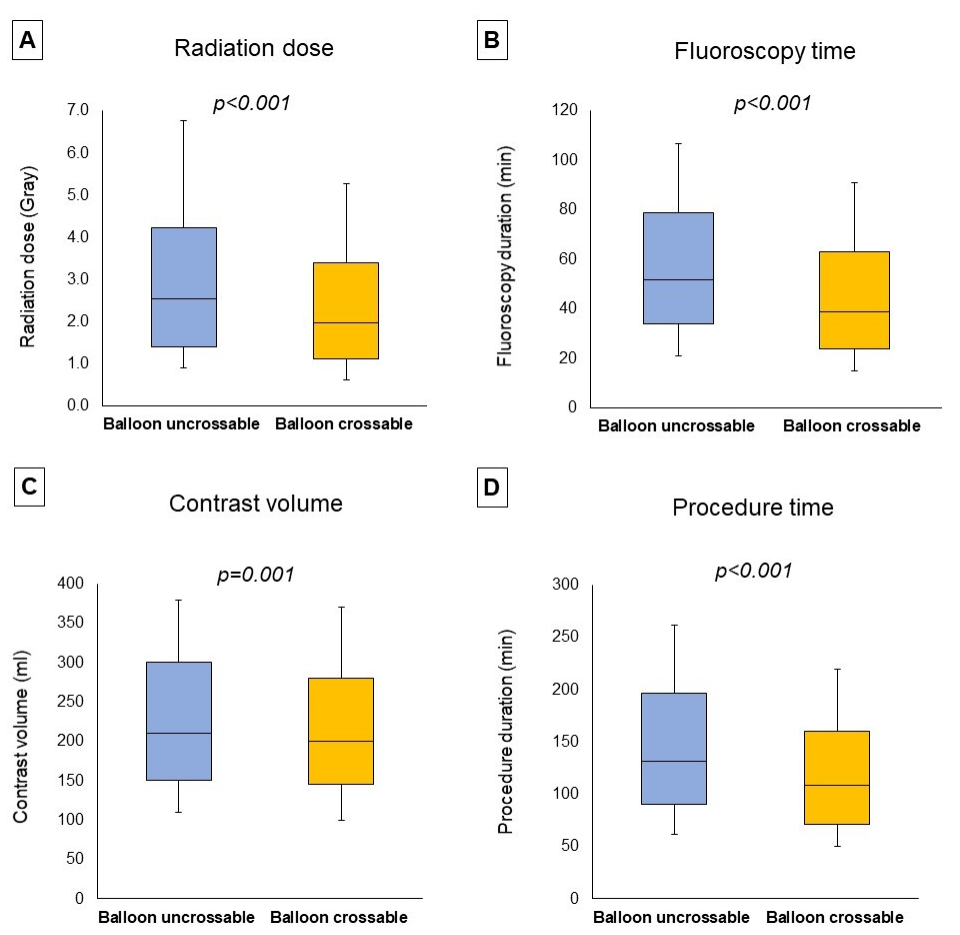
Figure 1. Procedural characteristics. The boxplots represent the median radiation dose ( A ), median fluoroscopy time ( B ), median contrast volume ( C ), and median procedure time ( D ) classified according to the presence of balloon uncrossable lesions, showing (from top to bottom): maximum, Q3, median, Q1, minimum.